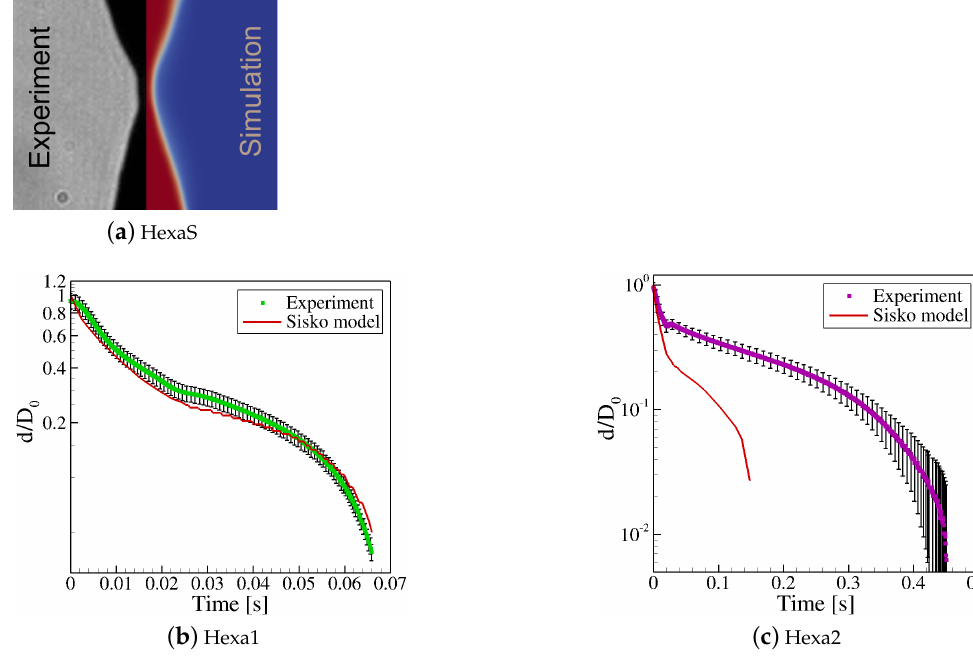
Figure 6. Comparison between the numerical predictions of the constitutive models and the experi- mental results obtained in the CaBER for the three inks: ( a ) HexaS, ( b ) Hexa1, and ( c )